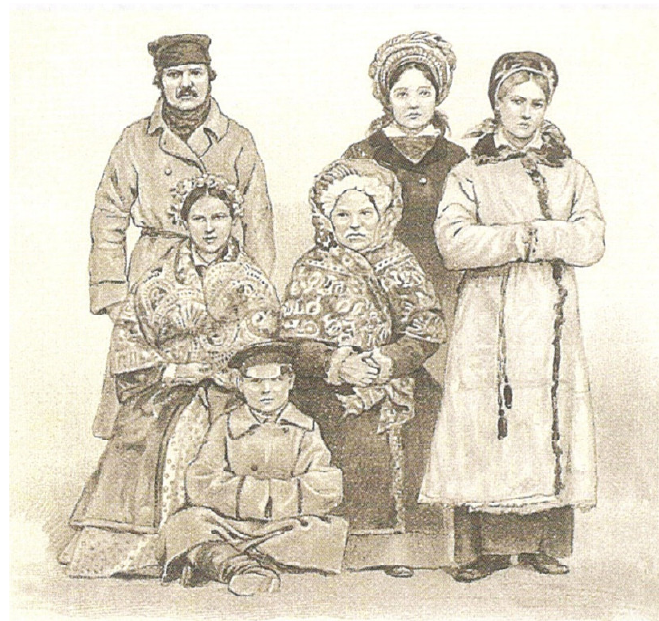
Figure 5. Lithuanians. The end of the 19th century [54].